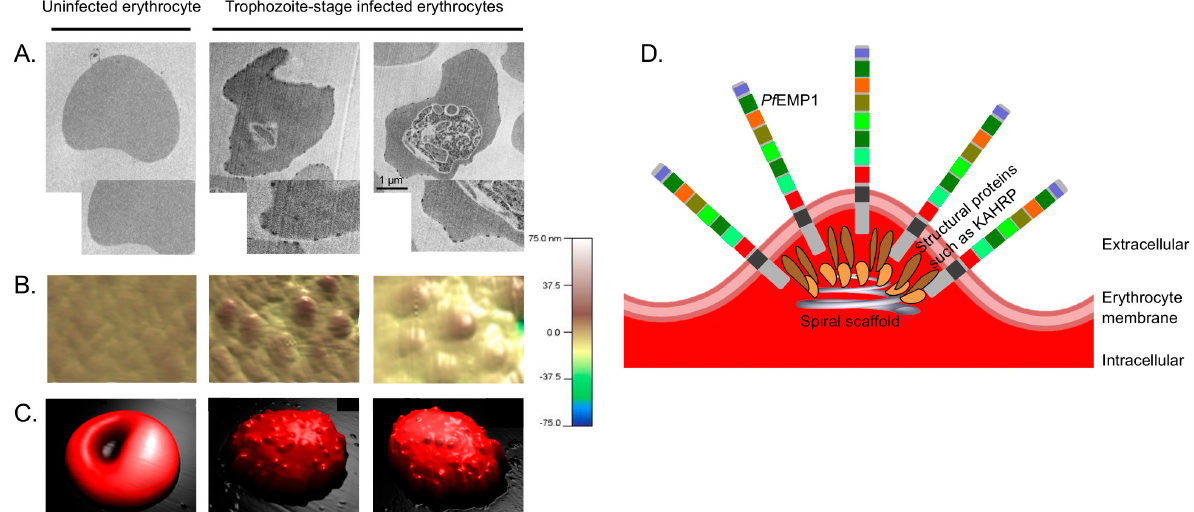
Figure 2. The knobs of P f lEs. ( A ) Transmission electron micrographs of uninfected and synchronised trophozoite-stage P. falciparum culture 24–28 h post-infection. The parasites were cultivated in the presence of human serum (10%), and the Pf IEs were subjected to gelatin sedimentation to enrich knobby Pf IEs [40,48]. ( B , C ) atomic force microscopic three-dimensional images of the surface of uninfected and trophozoite-stage Pf IEs [40]. Images in ( B ) show magnifications directly from the membrane surface of the erythrocytes shown in ( C ). ( D ) Simplified schematic illustration of the structure of knobs.